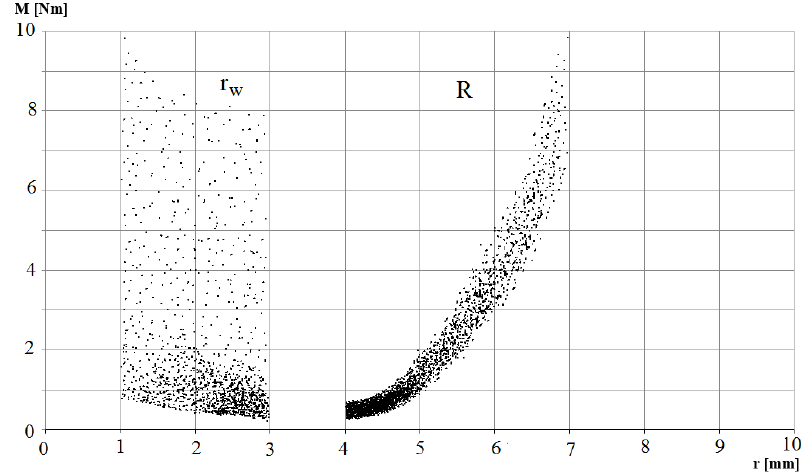
Figure 16. Dependence of the torque M on the radius r w and on the radius R.